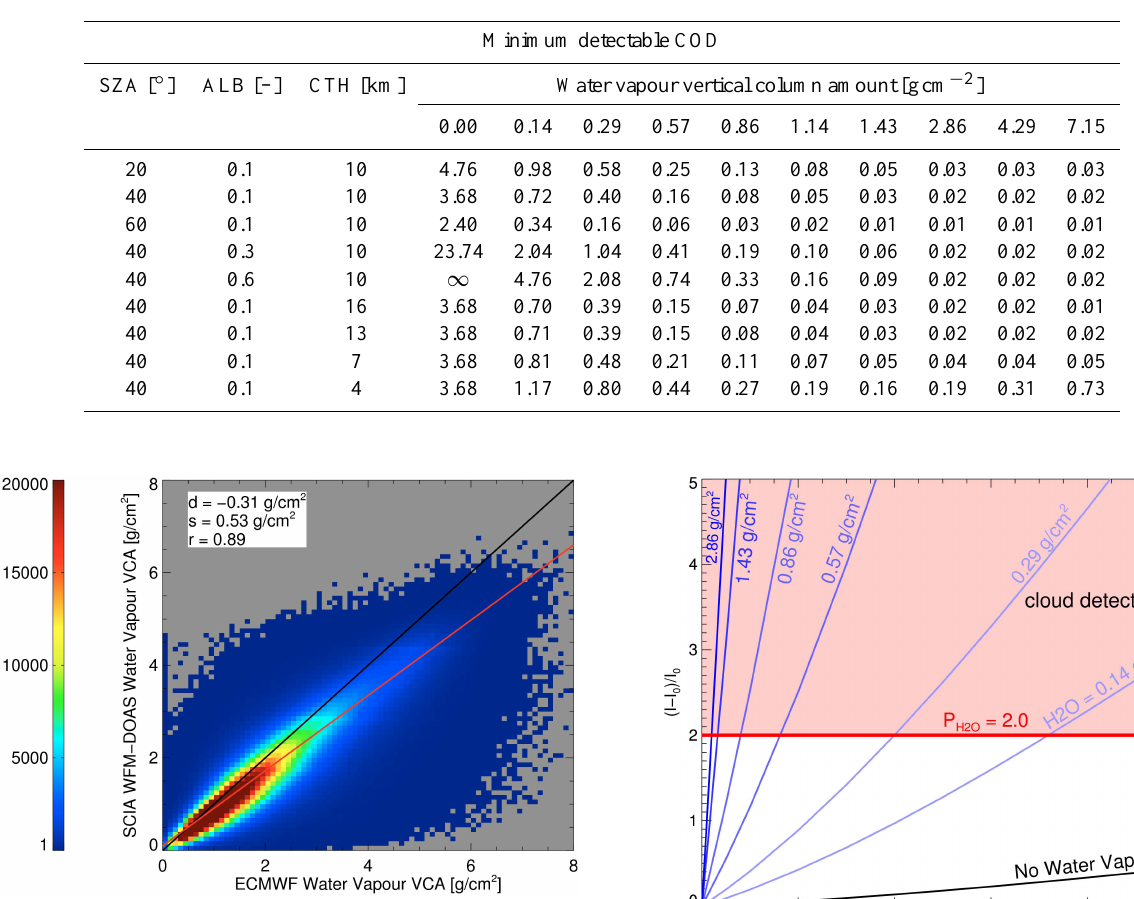
Table 1. Minimum detectable cloud optical depth (COD) for the cloud detection algorithm based on a threshold method for the radiance of the saturated water vapour absorption band at 1.4µm for various simulation scenarios as defined by solar zenith angle (SZA), surface albedo (ALB), cloud top height (CTH) and water vapour vertical column amount. The default aerosol scenario and a cloud geometrical thickness of 0.5km have been used for all scenarios. ∞ means that even clouds with large COD are not detected.